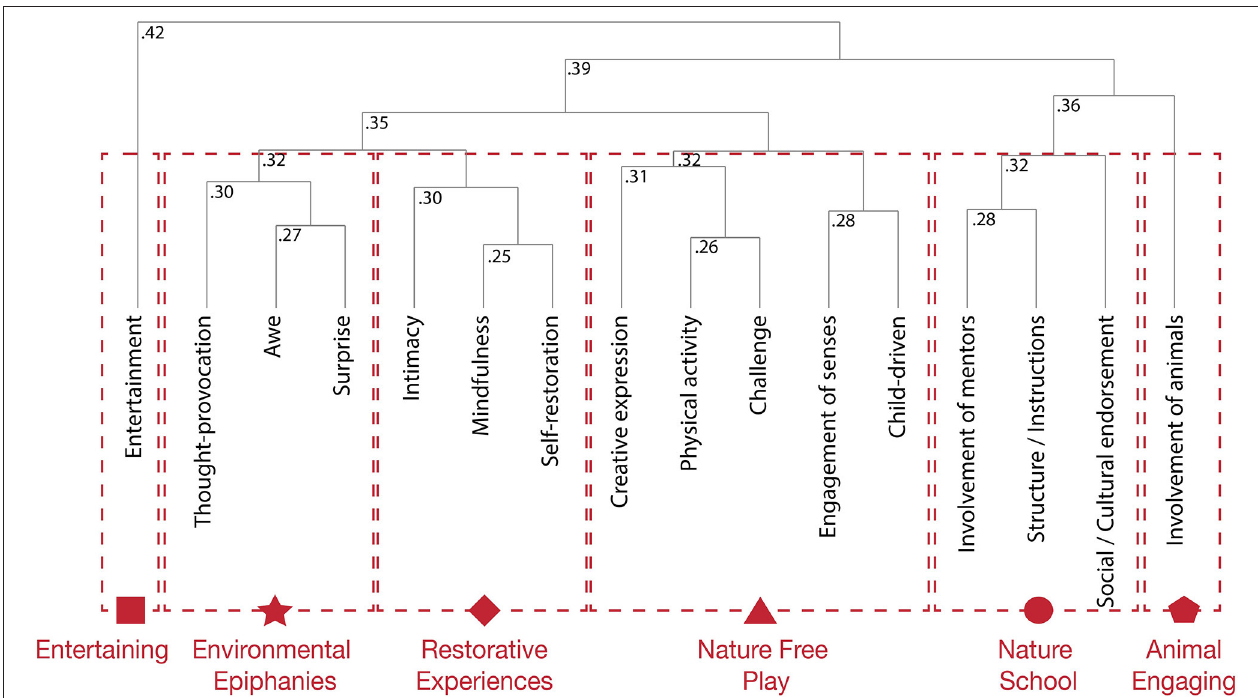
FIGURE 2 | Dendogram obtained from the hierarchical analysis of dissimilarity of qualities of SNS using Gower’s coefficient with height coefficients. The clusters of “entertainment” and “involvement of animals” had been independently clustered as “entertaining” and “animal engaging.” The remaining qualities of SNS were clustered into four different macro categories of nature situations: environmental epiphanies, restorative experiences, nature free play, and nature school.